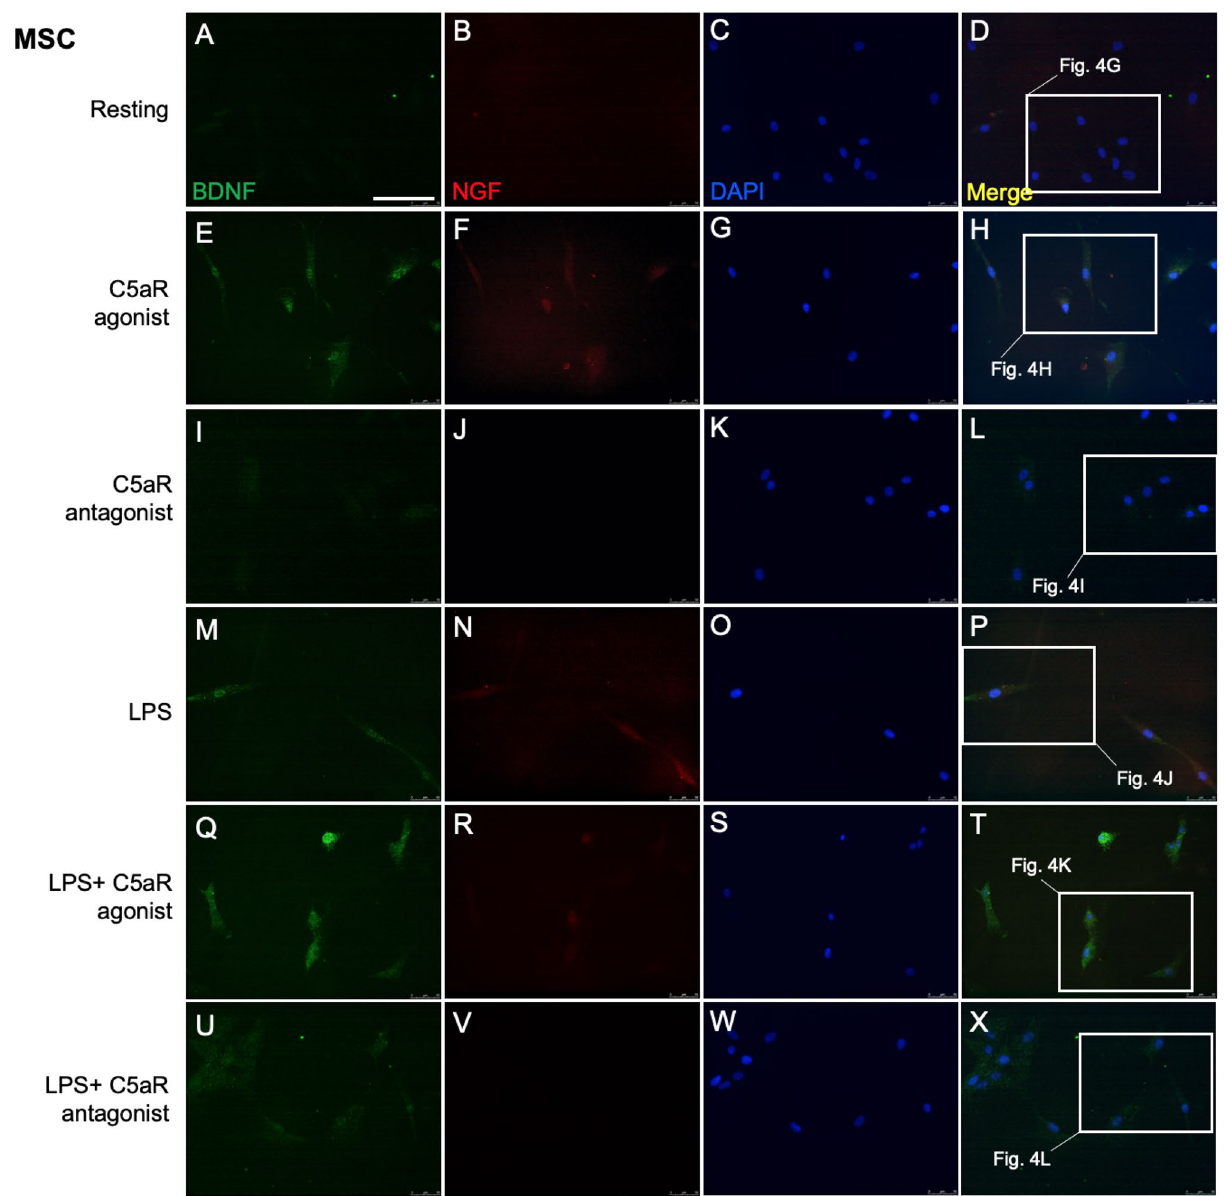
Figure 3. BDNF and NGF are weakly expressed in BM-MSCs. Cultured cells were treated with C5aR- agonist or antagonist for 48 h and then stimulated with LPS for 1 h, and fixed and stained accordingly. Immunofluorescence double staining was used to analyze the expression of BDNF and NGF. Anti-BDNF (green) and anti-NGF (red) were found weakly co-localized in the cytoplasm of BM-MSCs in C5aR-agonist treated cells after 48 h of treatment. Staining was observed in C5aR-agonist and LPS + C5aR-agonist treated cells. For each condition, negative controls, performed by replacement of the BDNF and NGF primary antibodies and secondary antibody used to detect BDNF was Alexa-488 (green) and NGF through Alexa-594 (red); nuclei were counterstained with DAPI (blue). Scale bar: 100